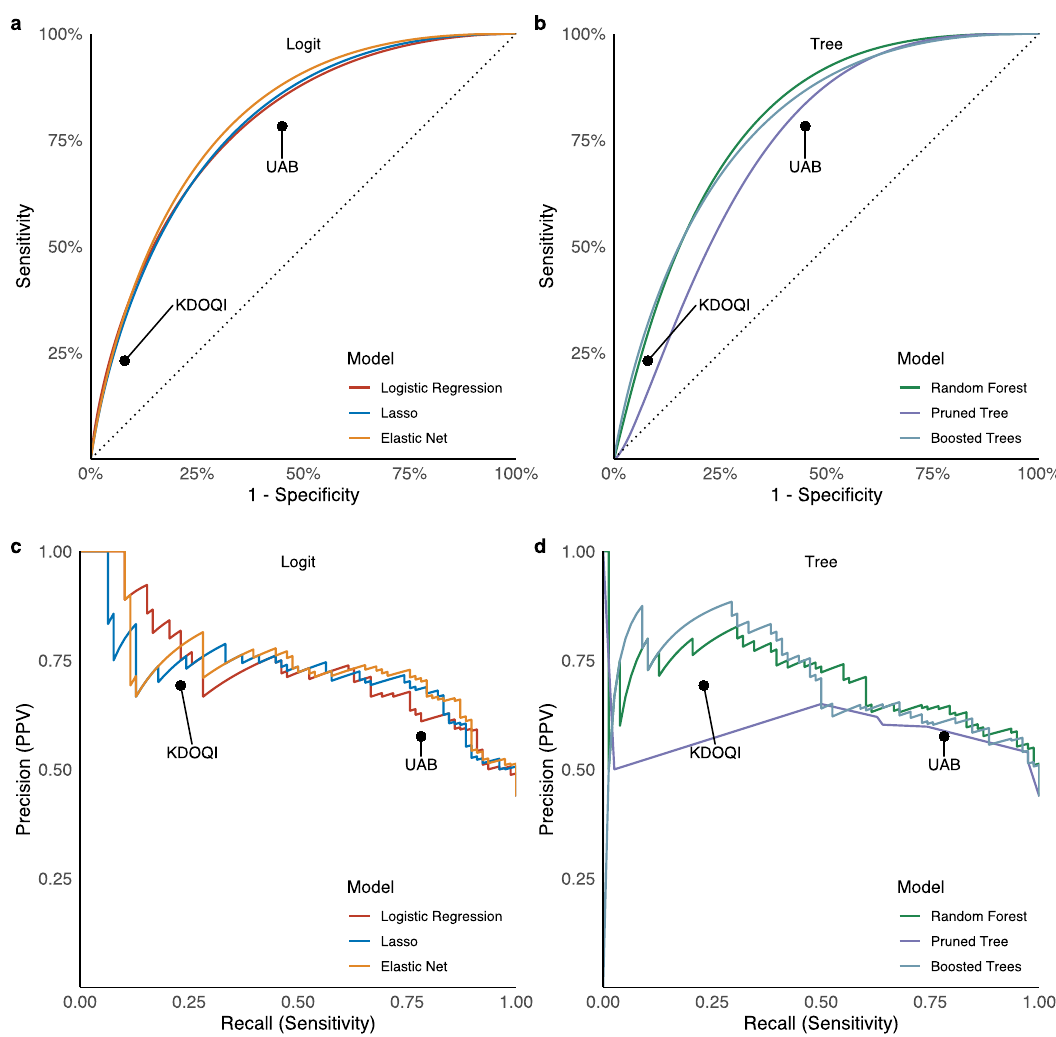
Fig. 3 Model discrimination performance. Receiver operating characteristic curves a , b and precision-recall curves c , d depicting model performance on testing data after hyperparameter tuning and training. Panels are strati fi ed by model type, either logit a , c or tree b , d for visual clarity. Colors identify the speci fi c model (red: logistic regression, blue: lasso, orange: elastic net, green: random forest, purple: pruned classi fi cation tree, light blue: boosted trees). Performance of University of Alabama at Birmingham (UAB; ≥ 500 mL/min and ≥ 4 mm) and Kidney Disease Outcomes Quality Initiative (KDOQI; ≥ 600 mL/min and ≥ 6 mm) ultrasound threshold criteria also displayed as labeled